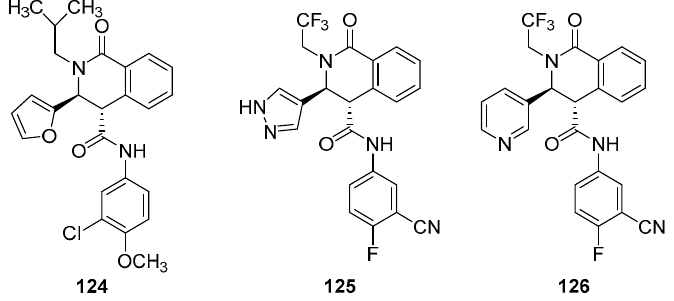
Figure 2. Tetrahydroisoquinolone carboxanilides with antimalarial activity. In a recent application of the CCR, the condensation of DNA-conjugated imines with HPA enabled the synthesis of an isoquinolone core-focused DNA-encoded library [76,77]. Castagnoli and Cushman used a 6-membered glutaric anhydride ( 19 ) and HPA derivative ( 129 ), respectively, for the preparation of pharmacologically active nitrogen analogues of the tetrahydrocannabinols ( 127 ; Scheme 41) [26,78] and isoquinolinones, such as tetrahydroprotoberberine alkaloids ( 131 ; Scheme 42) [27,79]. Stanoeva and co- workers have also performed di ff erent transformations on glutaric anhydride ( 19 ) to yield new substituted piperidin-2-ones [80].